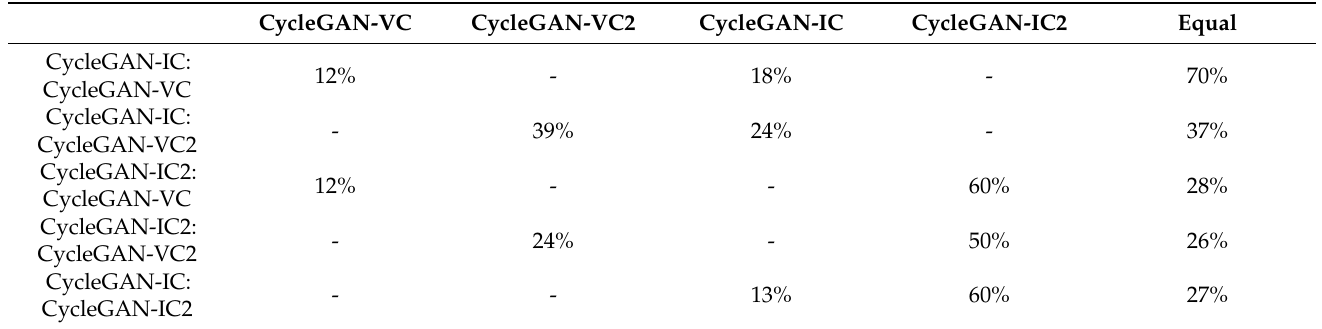
Table 5. The voting results of CMOS in humming to